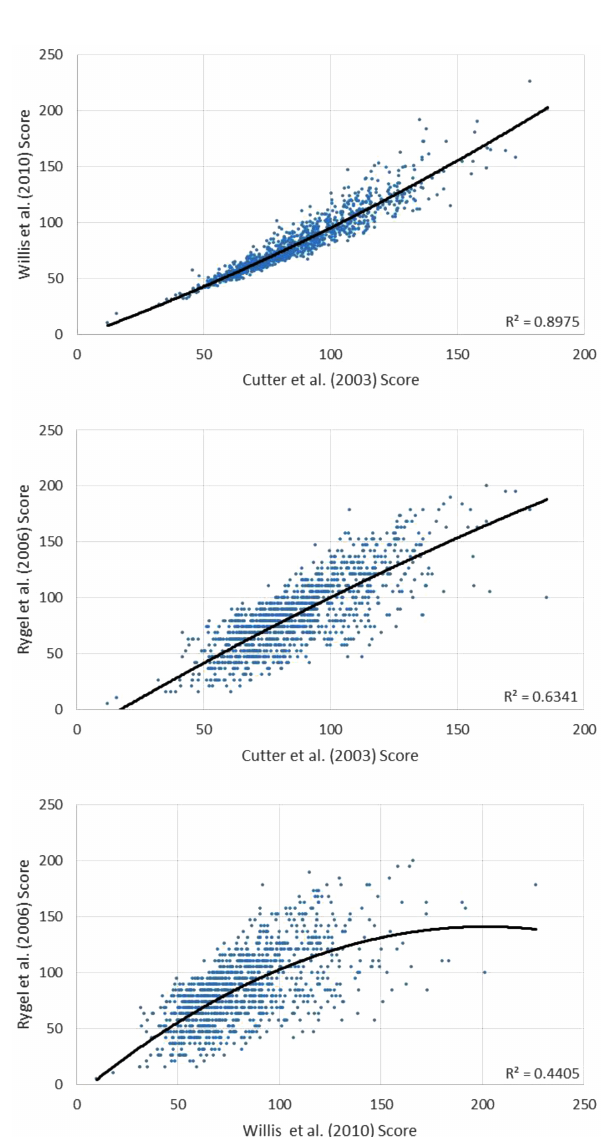
Figure 4. Correlation of social vulnerability index scores for the Parrett Catchment. Trend lines are